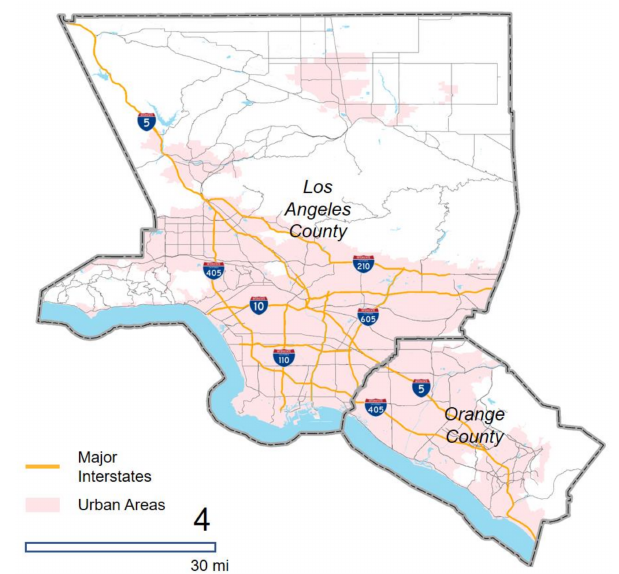
Figure 1. The Los Angeles Metropolitan Area and its major